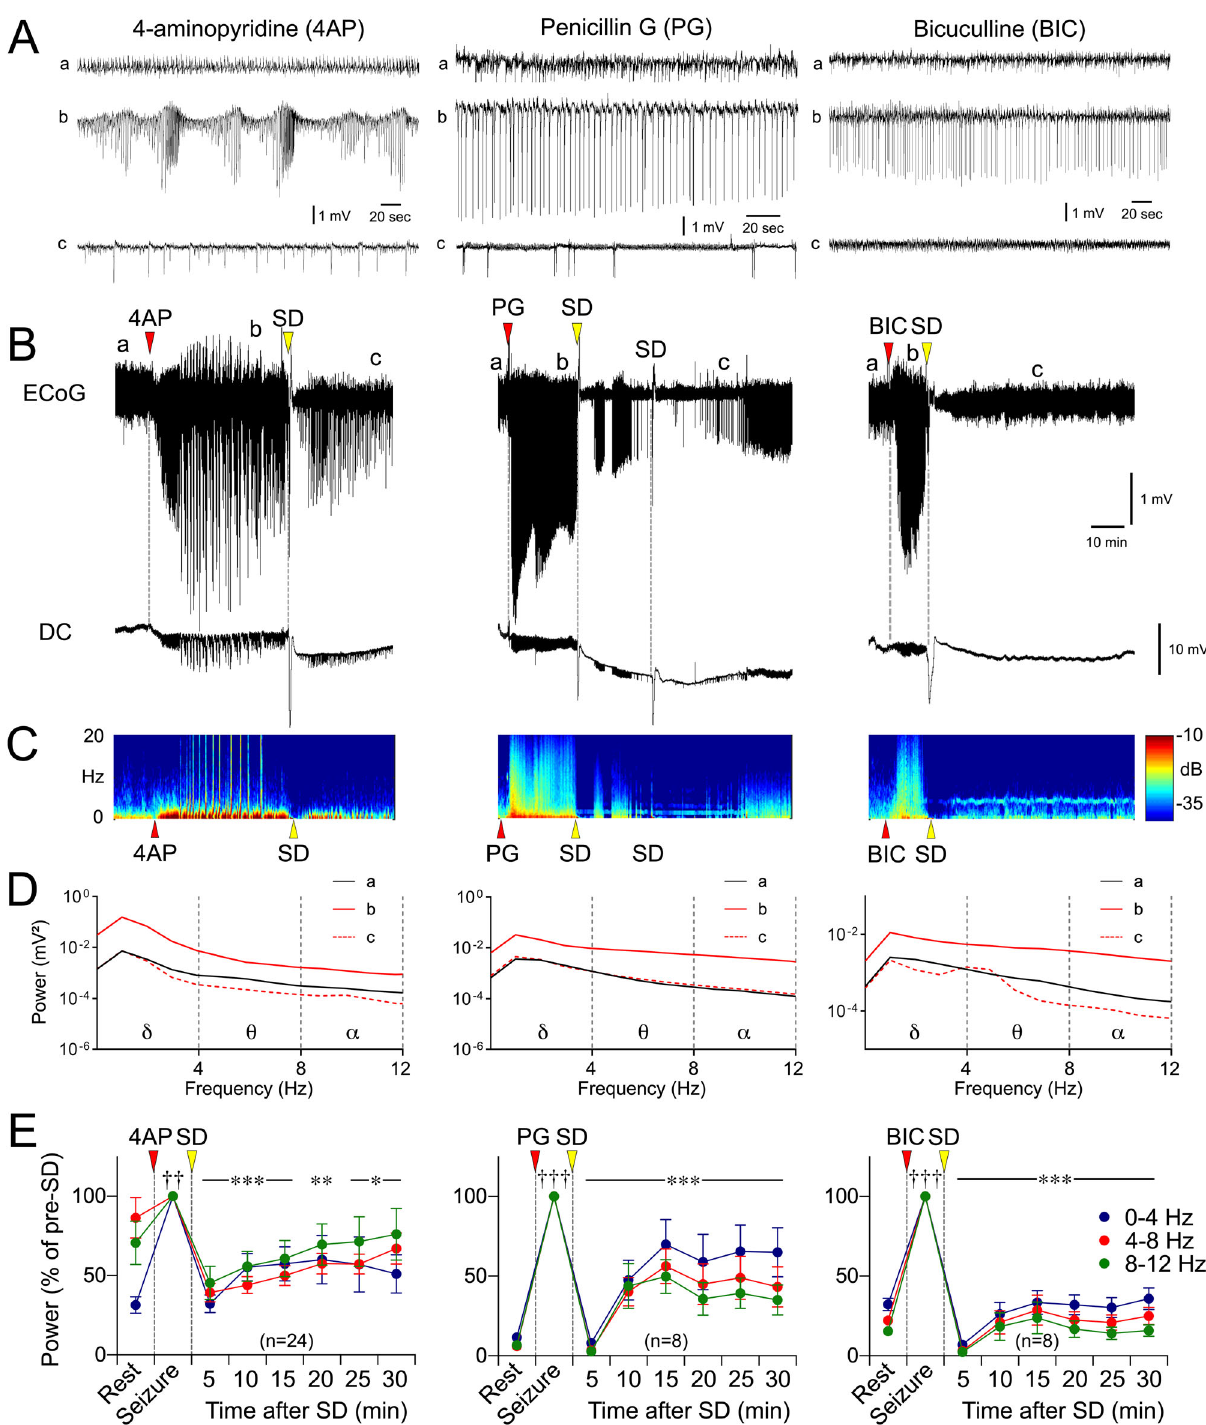
Fig. 5 Exogenously induced SD terminates focal cortical seizures and limits their reemergence. A Representative tracings show ECoG at baseline (a), during 4AP, PG, or BIC microseizures (b), and after an exogenously induced SD (c), as indicated on the full ECoG timeline ( B ). Recordings are from the drug application site, (E1, Supplementary Fig. 1B, b). Red arrowheads show the time of drug application. Induced SDs (yellow arrowheads) and the abrupt seizure termination are seen on the DC and ECoG tracings, respectively. Note that a second SD spontaneously originated from the seizure focus in this PG experiment. C Time – frequency-power spectra of the full timeline shown in B calculated using Thomson ’ s multitaper method also show an abrupt reduction in seizure power associated with SDs. D Power density at the three phases (a – c) computed using FFT further demonstrates the lasting seizure power reduction after SD. E Average ECoG power time course in δ (0 – 4 Hz), θ (4 – 8 Hz), and α (8 – 12 Hz) frequency bands show ECoG power at rest, during the seizure (5 min prior to SD, and every 5 min thereafter (5 – 30 min), expressed as % of pre-SD seizure power. All frequency bands show a signi fi cant reduction in seizure power for at least 30 min after SD. SD was induced at 37 ± 3 min (13 – 69) after 4AP application, 19 ± 0 min (17 – 20) after PG application, and 13±2 min (10 – 18) after BIC application (mean ± standard error and full range). Sample sizes are shown on the graphs. † - ††† p < 0.05 – 0.001 vs. R; *-*** p < 0.05 – 0.001 vs. S (two-way ANOVA for repeated measures; ±SEM). NATURE COMMUNICATIONS| (2021) 12:2206 |https://doi.org/10.1038/s41467-021-22464-x|www.nature.com/naturecommunications